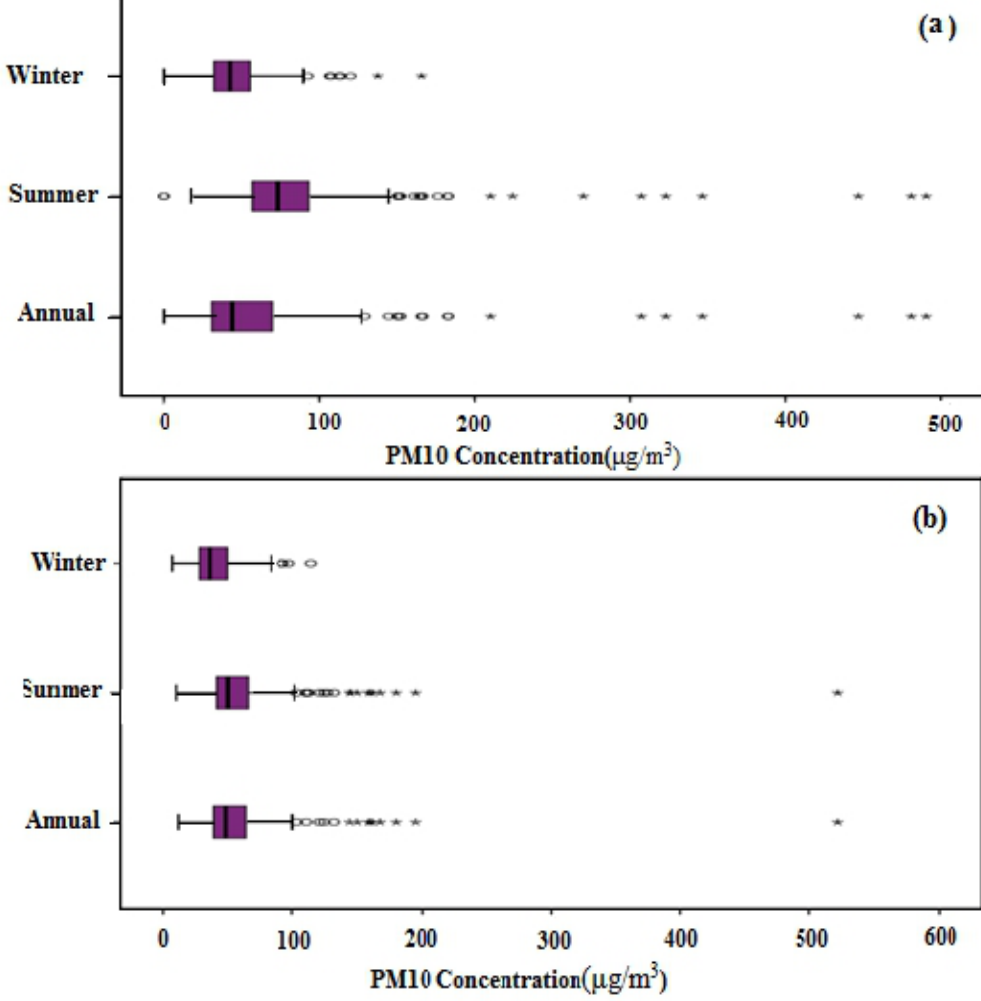
Fig. 2. Descriptive statistics of measured particulate matter with aerodynamic diameters <10 µm concentrations in Ilam, Iran, in 2013 (a), 2014